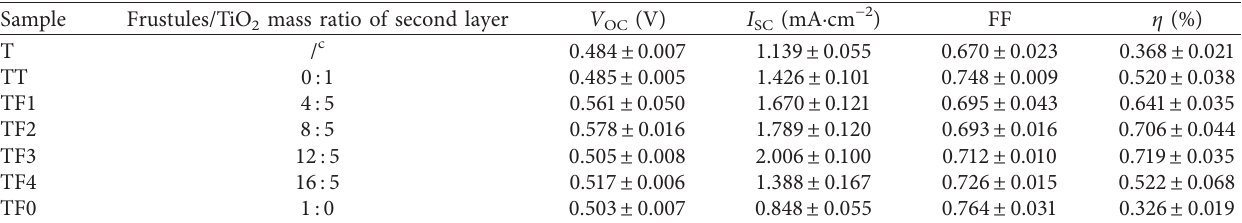
2 film electrodes (4 samples in each group).